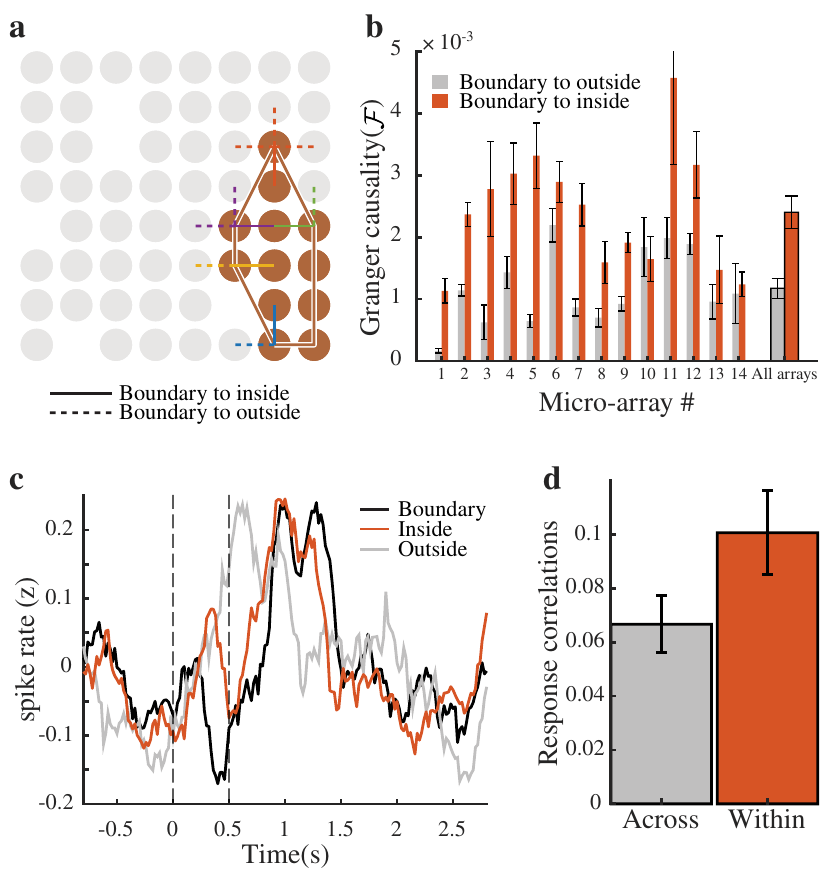
Fig. 5 | Moduleboundariesare sharp. a We use a partition ’ s convex hullto de fi ne its boundary, and then identify electrodes on the boundary that have a nearest neighbor that is inside the boundary and a nearest neighbor that is outside of the boundary(solidvsdashedlines). b MeanpairwiseconditionalGrangercausalityfor boundary to inside and boundary to outside pairs for the individual MEAs and